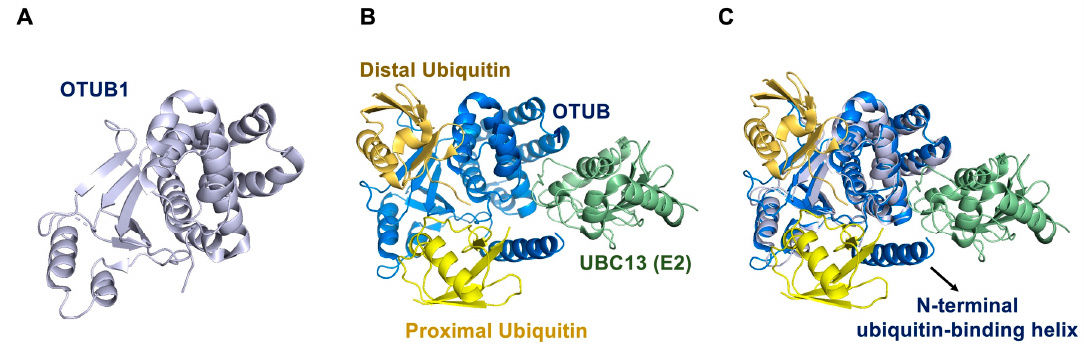
Figure 4. The structure of OTUB1 and E2. ( A ) Crystal structure of OTUB1. ( B ) Crystal structure of OTUB1-ubiquitin aldehyde-UBC13~Ub. ( C ) Superposition of OTUB1 structures in ( A , B ). Ubiquitin (yellow), UBC13 (green), OTUB1 without ubiquitin (white-blue), OTUB1 with ubiquitin (blue), N-terminal ubiquitin-binding helix (blue) is disordered in the apoenzyme. (PDB: 4DHZ and 2ZFY).